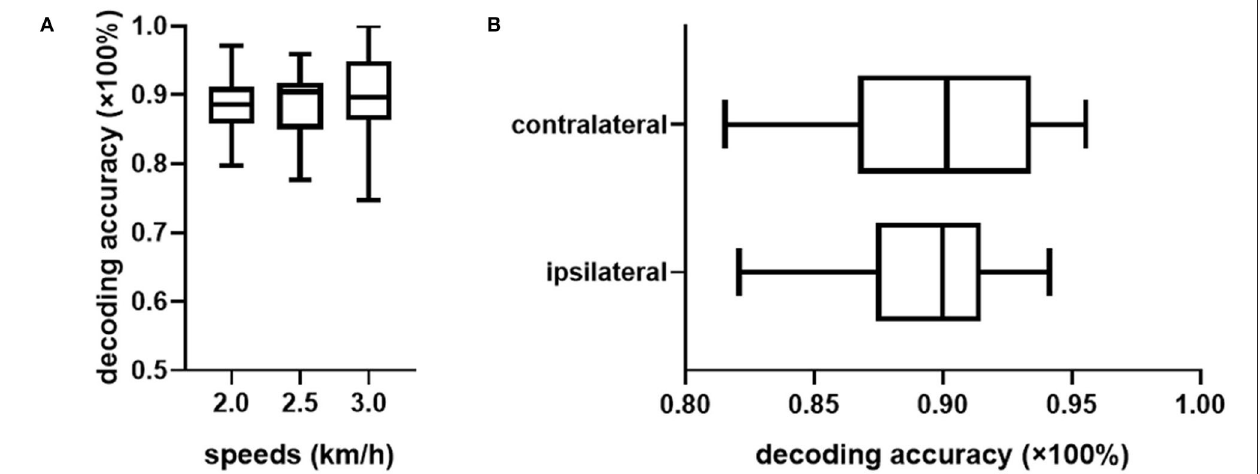
FIGURE 3 | Overall evaluation of the gait phase decoder performance across the healthy subjects. (A) Shows the decoding accuracy under three predefined speeds. (B) Compares the decoding accuracy fusing sEMG sensor feedback from different